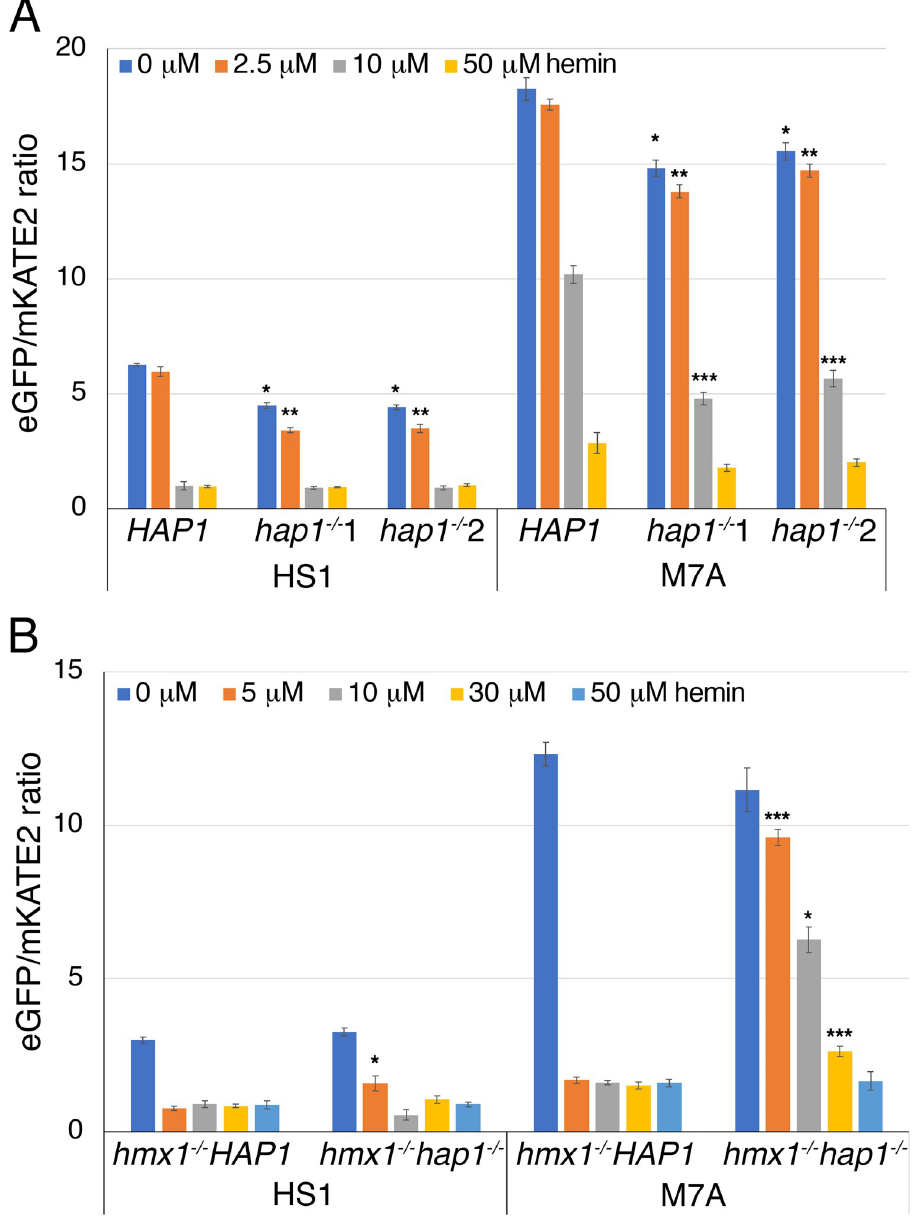
Fig 4. HAP1 affects cytoplasmic heme homeostasis and uptake of external heme. (A) Cells of the indicated phenotype ( HAP1 = SN148, hap1 -/- = KC1406) were transformed with the HS1 (high-affinity heme sensor)—or M7A (medium-affinity heme sensor) -expressing plasmids and grown in YPD + 1 mM ferrozine and the indicated hemin concentrations for 5 hours. Each data point represents the average of three independent cultures, and the error bars represent the standard deviation. The statistical significance of each mutant data point compared to the corresponding wild-type data point is indicated as � = p < 10 − 4 , �� = p < 10 − 6 , ��� = p < 10 − 8 . (B) Cells of the indicated phenotype ( hmx1 -/- HAP1 = KC1251, hmx1 -/- hap1 -/- = KC1426) were transformed with the HS1 or M7A sensor plasmids and grown and assayed as in A. ratios, i.e. higher cytoplasmic heme concentrations, compared to the wild-type: in the presence of 2.5 μ M hemin in the medium, the high and medium affinity sensors gave 40% and 20% lower signals, respectively, in the hap1 -/- mutant strains vs. the wild-type strain. In 10 μ M and